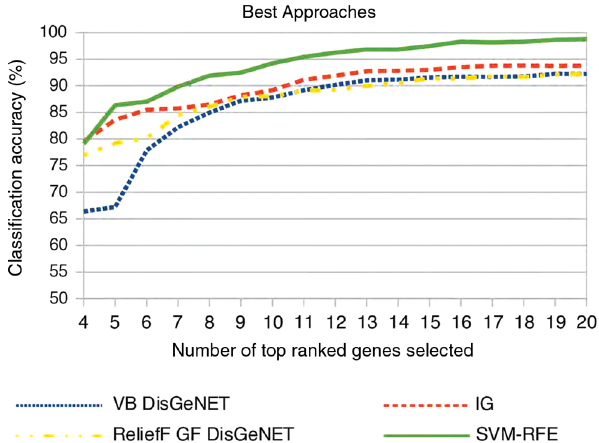
Figure 8: Classification accuracies on dataset II of the best performing approaches for the respective traditional gene se- lection